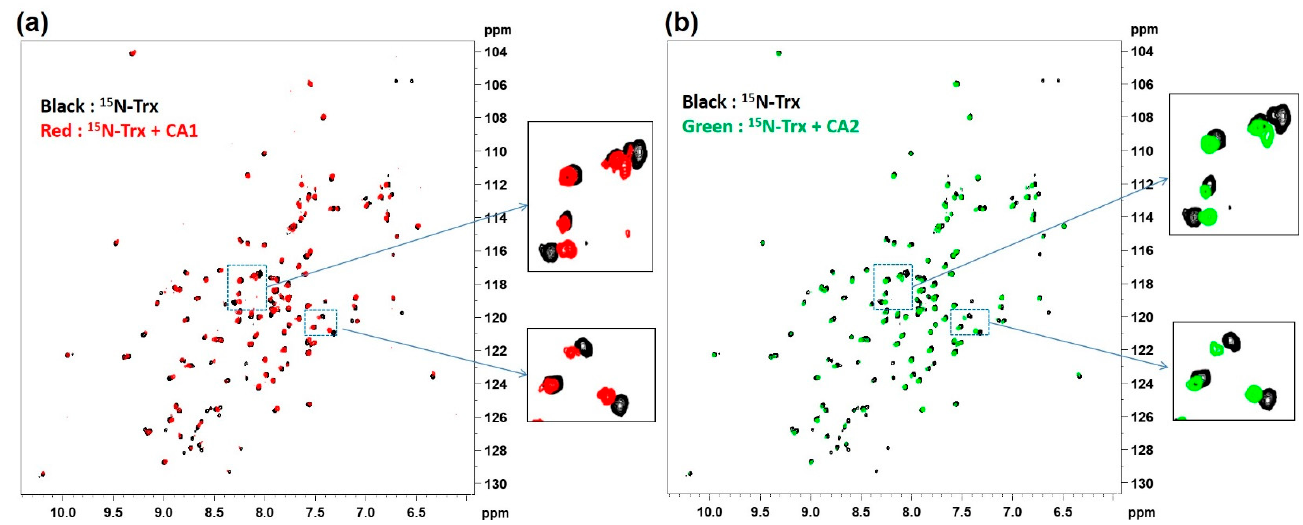
Figure 3. NMR confirmation of Trx interaction with the contrast agents CA1 and CA2. The results of 1 H- 15 N heteronuclear single quantum coherence (HSQC) NMR spectral studies performed using 15 N-labeled Trx only, 15 N-labeled Trx with CA1 ( a ), or 15 N-labeled Trx with CA2 ( b ) are shown. Compared with the spectra of Trx alone (black), there are substantial chemical shifts when the contrast agents CA1 and CA2 are added to the 15 N-labeled Trx, with both agents being similar in terms of the extent of the induced shift.